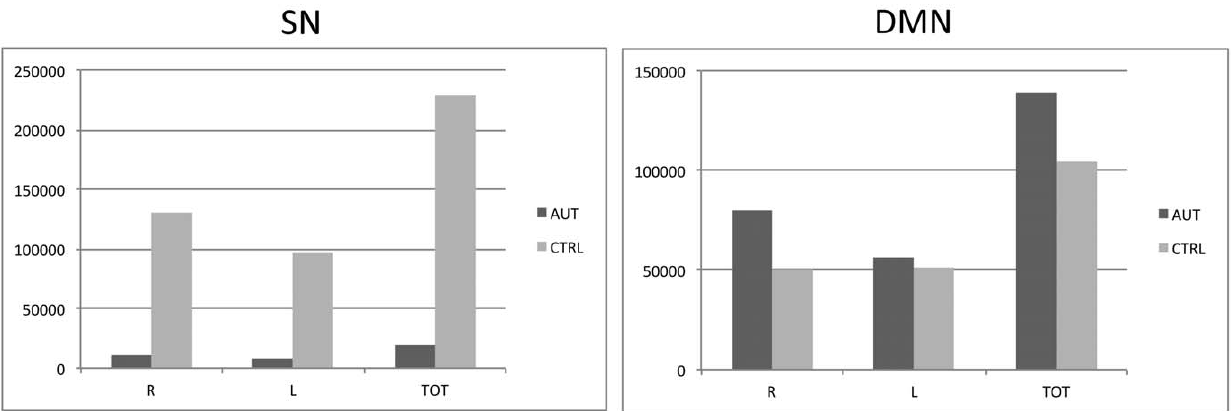
Figure 3. Group differences in network volume. Plots of voxel counts by group indicate substantially restricted network extent in the SN of autistic subjects, whereas the DMN is more spatially extensive in the autistic group. Y-axis scale is voxel number from associated statistical maps. AUT, autism group; CTRL, control group; DMN, default mode network; L, left; R, right; SN, salience network.